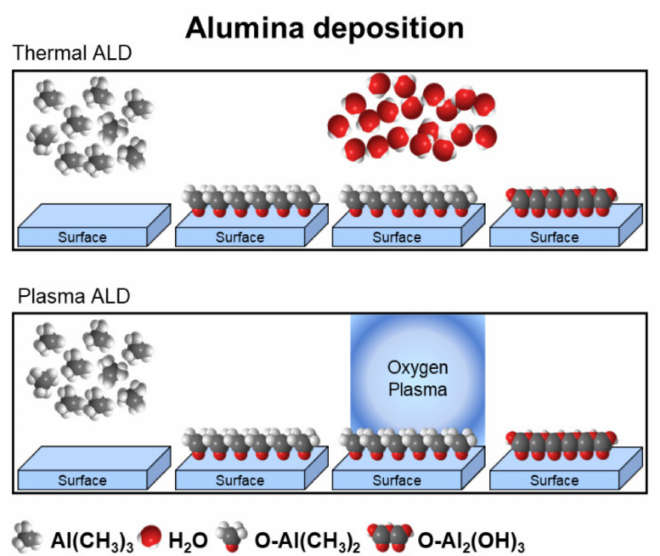
Figure 17. Schematic representation of one cycle of Al 2 O 3 by thermal ALD and plasma ALD techniques. In plasma ALD, the H 2 O co-reactant is replaced with a plasma exposure (e.g., O 2 plasma) to grow metal